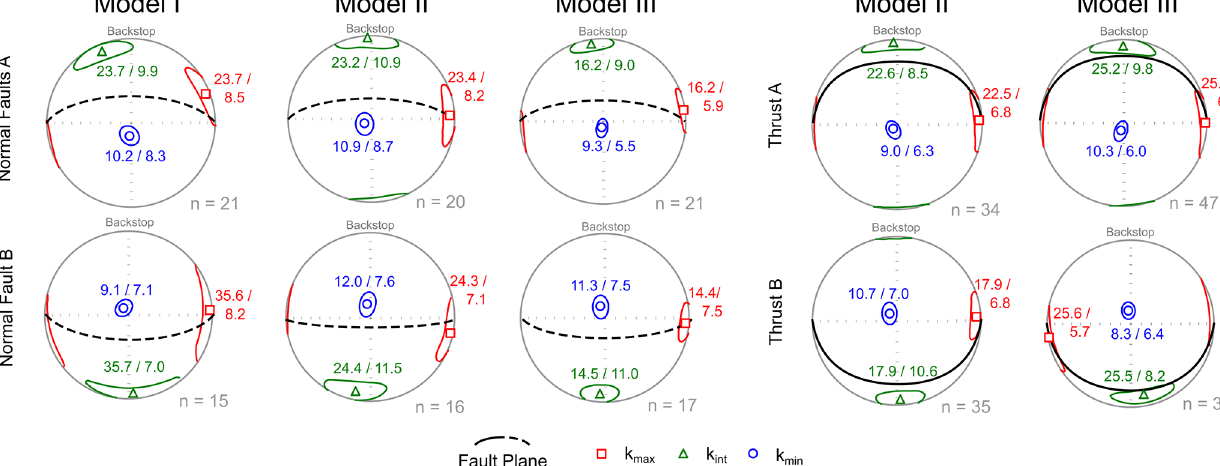
Figure 6. Comparison of orientation of the mean principal axes with confidence ellipses for normal faults and thrusts. The numbers next to each confidence ellipse are the angles of the ellipse itself, which give information on the length and width of the ellipse in degrees (Jelínek, 1977). A comparison of the areas away from the faults is given in Fig.